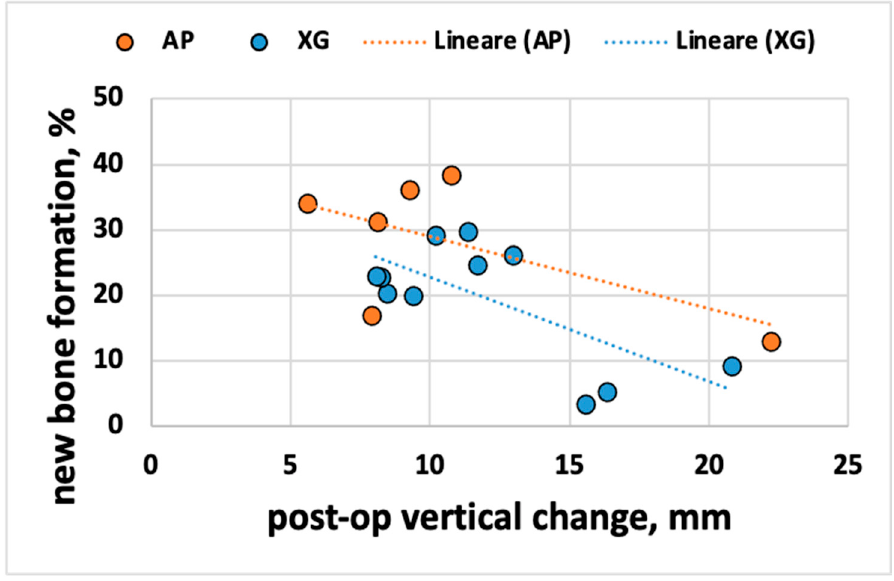
Figure 6. Post-operative vertical change and NBF for each biomaterial .